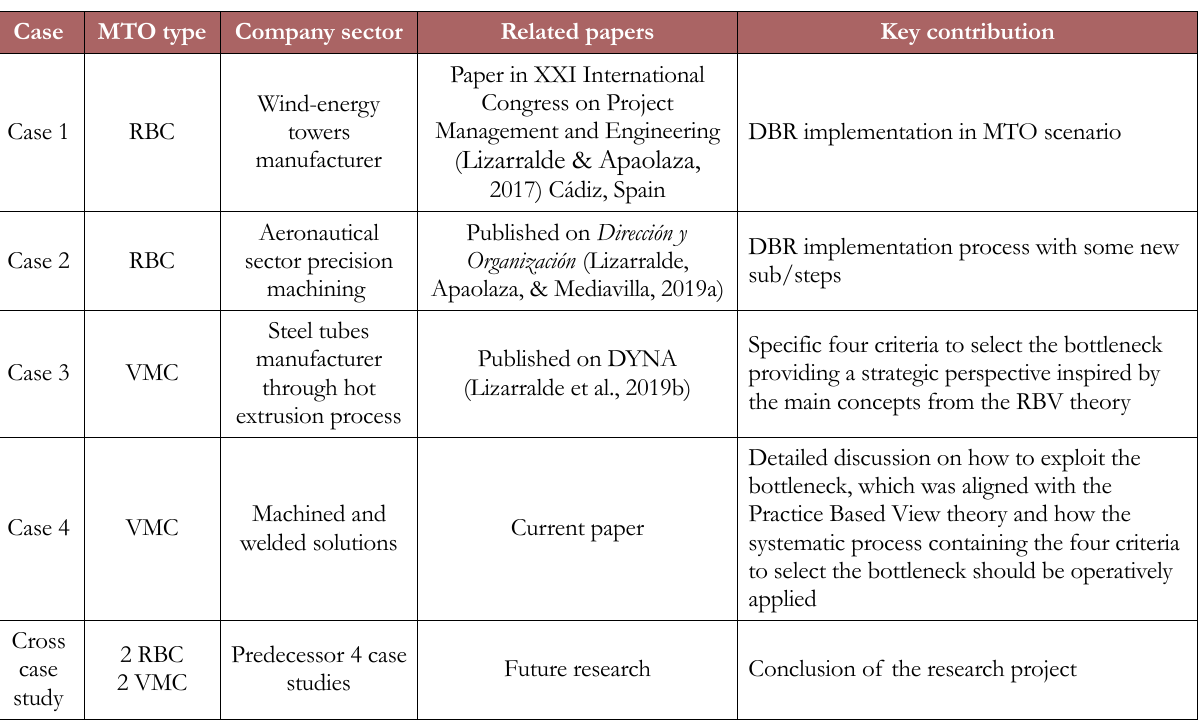
Table 2. Research program cases and related